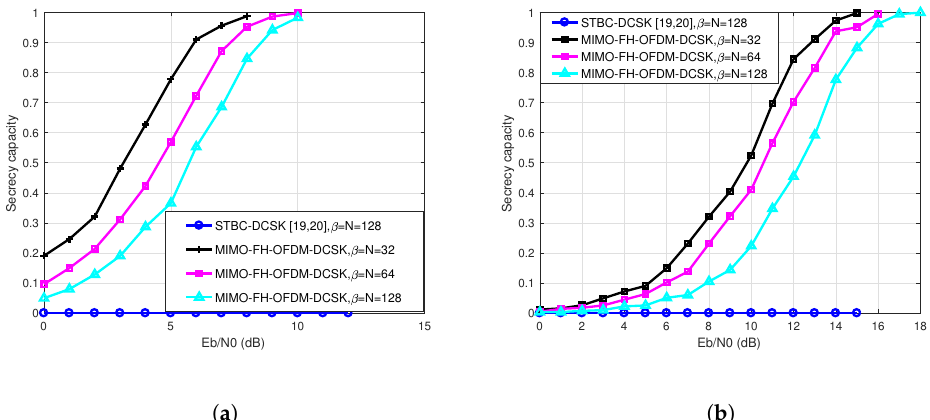
Figure 8. The secrecy capacity comparison between the proposed system and the benchmark scheme (STBC-DCSK) [19,20]. ( a ) AWGM channel; ( b ) Rayleigh channel. Table 3. Secrecy capacity comparison between the proposed system and the benchmark scheme (STBC-DCSK) [19,20] in AWGN channel.